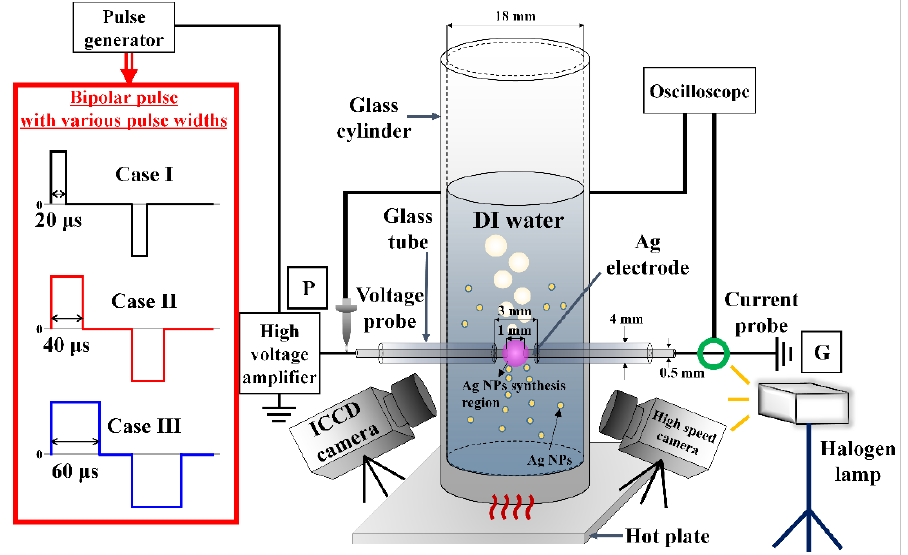
Figure 1. Schematic diagram of liquid plasma reactor and measurement setup used in this study.